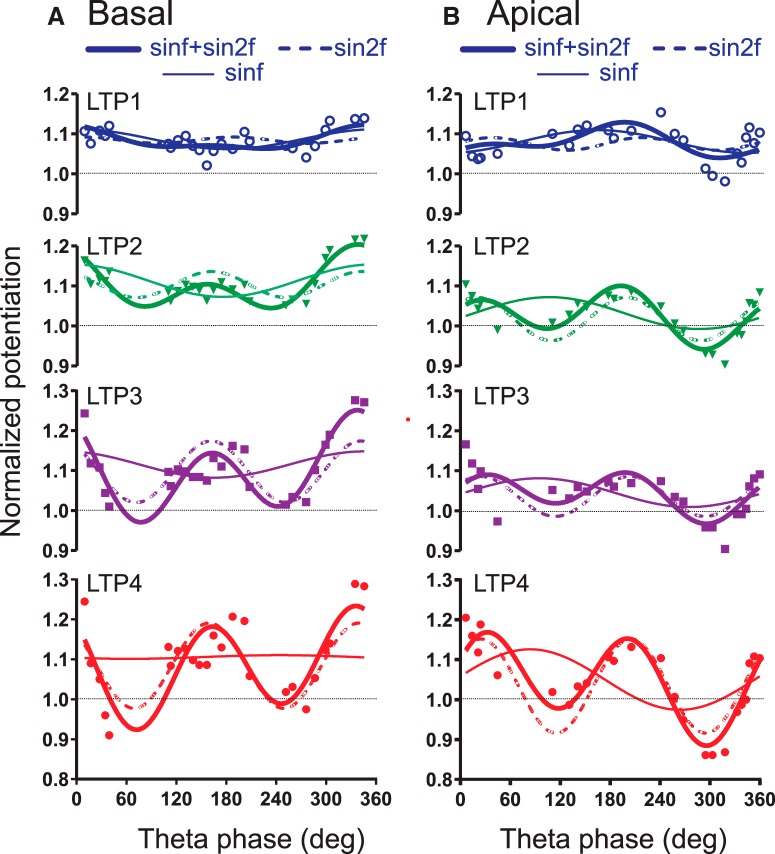
Basal and apical dendritic potentiation in relation to SLM θ phase of burst onset, averaged for different time periods post-bust. A, Individual normalized basal dendritic slopes (symbols) were averaged (three- or four-point running average) with phase, and then curve-fitted with a single 1st harmonic plus constant (sinf), a 2nd harmonic plus constant (sin2f), or the sum of 1st and 2nd harmonics plus constant (sinf+sin2f). From top to bottom, LTP1 (averaged for 0–30 min post-burst), LTP2 (30–60 min), LTP3 (60–90 min), and LTP4 (90–120 min post-burst). Other than LTP1, data points of all other periods show a good curve fit by a 2nd harmonic alone, or the sum of 1st and 2nd harmonics. B, Same as A for the apical dendritic response. Again, LTP2–LTP4 show good fit by a 2nd θ harmonic, and better by a sum of 1st and 2nd θ harmonics. The 2nd θ harmonic modulation of either basal or apical LTP increased with time post-burst.